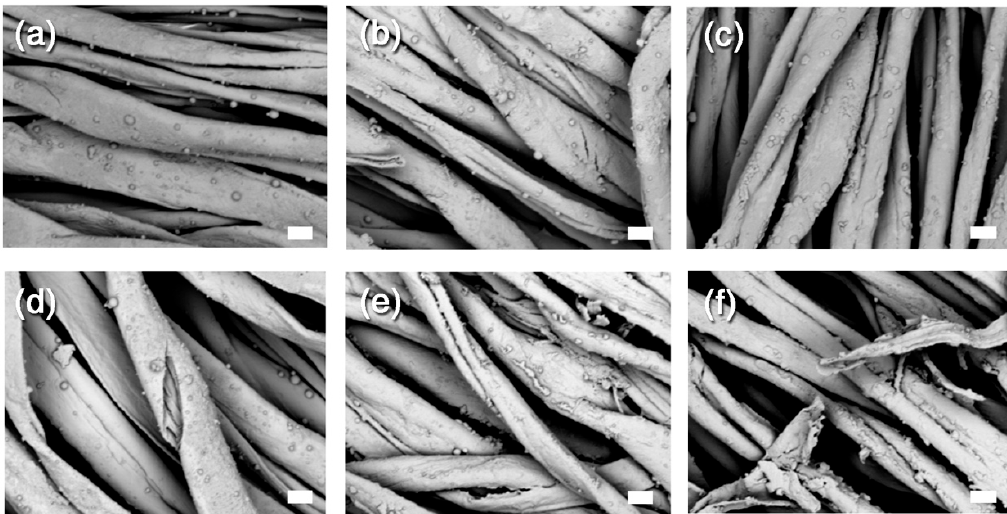
Figure 6. SEM images of samples belonging to the second set of samples, before and after the artificial ageing. ( a ) T4 before ageing; ( b ) T5 before ageing; ( c ) T7 before ageing; ( d ) T4 after ageing; ( e ) T5 after ageing; ( f ) T7 after ageing. The scale bar is 10 µm in all the images (1000× magnification).